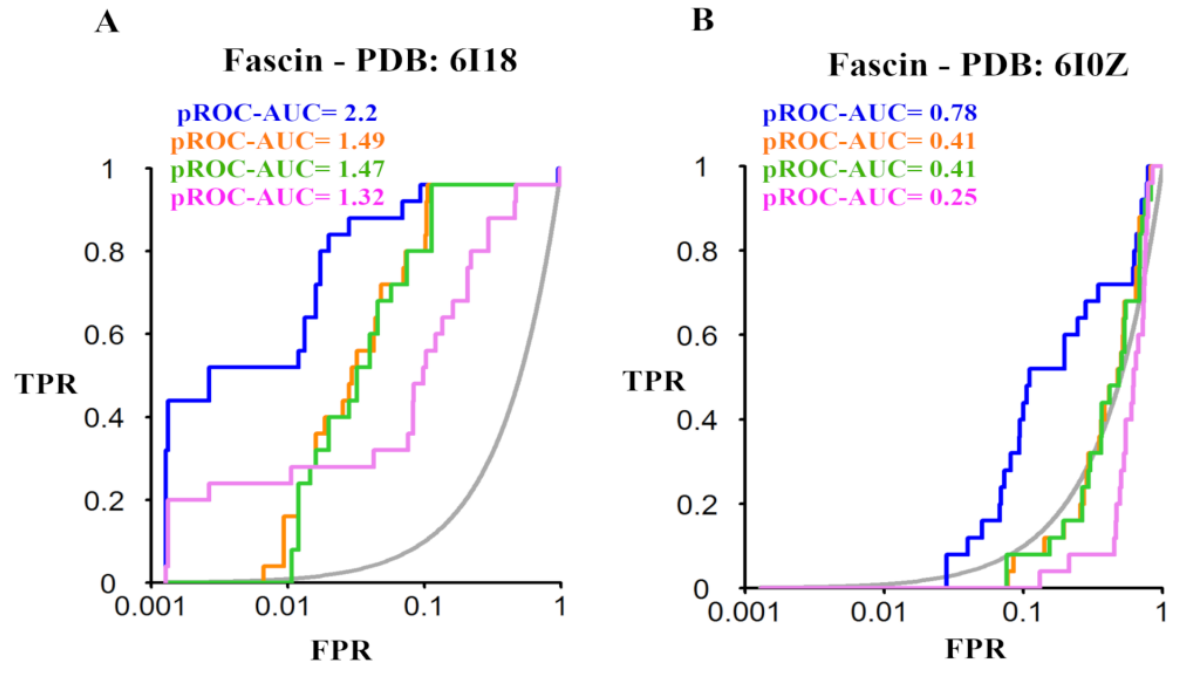
Figure 2. pROC plots of benchmarking analysis displaying the screening performance against Fascin (PDB ID: 6I18) and Fascin (PDB ID: 6I0Z) for ( A , B ), respectively. The curves of the docking tools PLANTS, Autodock vina, VinaXB, and MOE are represented by blue, orange, green, and magenta lines, respectively, while the grey line indicates the random screening performance. The true-positive rate (TPR), y -axis, represents the detected bioactives fraction, while the false-positive rate (FPR), x -axis, is the decoys retrieved fraction from a score − ordered list of all